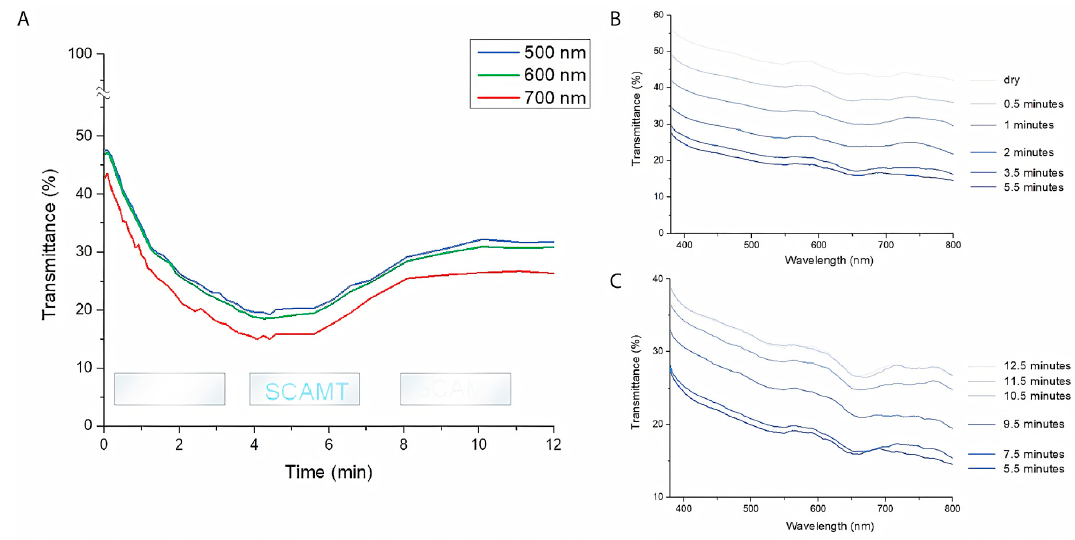
Figure 8. The graphs of the kinetic dependences of the transmittance on time at the wavelengths of 500, 600, and 700 nm ( A ), wavelength after adding water ( B ), and the gradual drying of the sample ( C